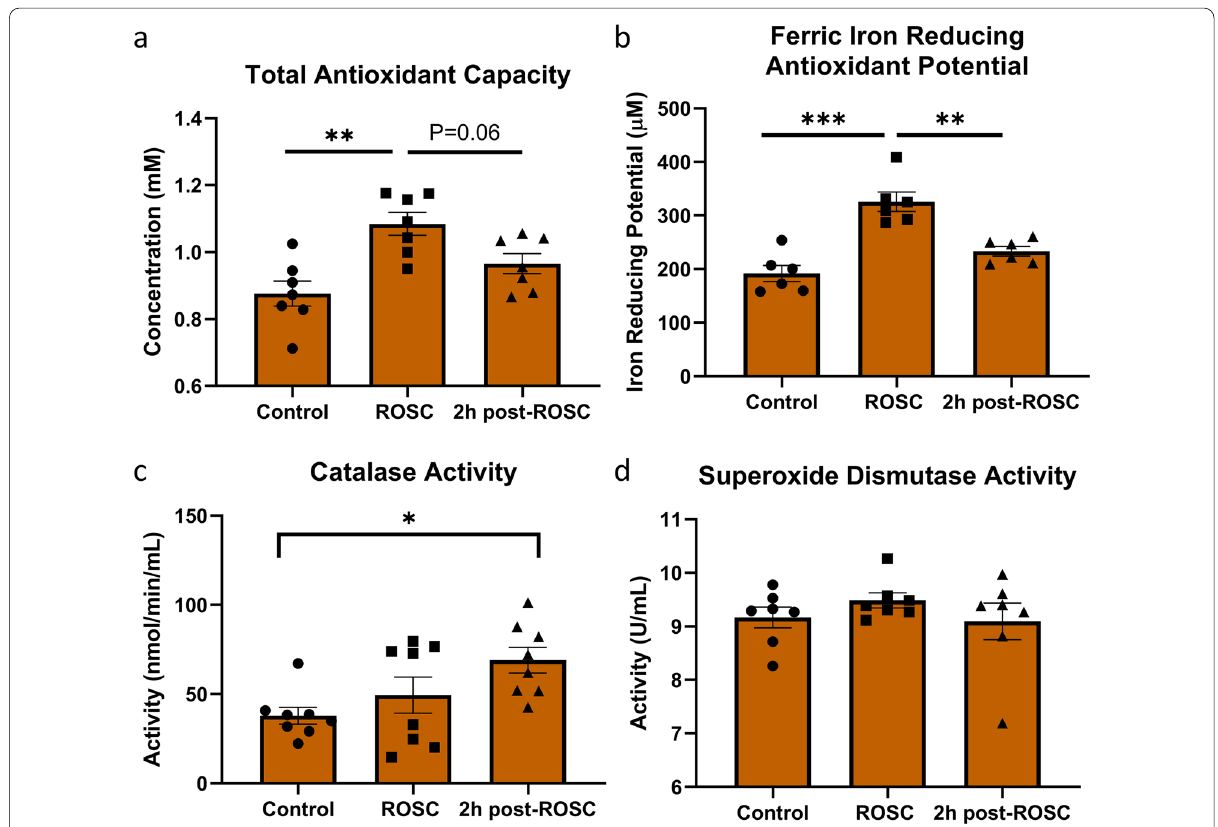
Fig. 4 Increased antioxidant levels during ischemia. a Total Antioxidant Capacity is increased at ROSC in rats. b Ferric Iron Reducing Antioxidant Potential is increased at ROSC in rats. c Significantly increased catalase activity is seen only when compared between 2 h post-ROSC and control in rats. d No changes are observed in superoxide dismutase activity at ROSC and 2 h post-ROSC in rats. *p < 0.05, **p < 0.01, and ***p < 0.001; ROSC, return of spontaneous